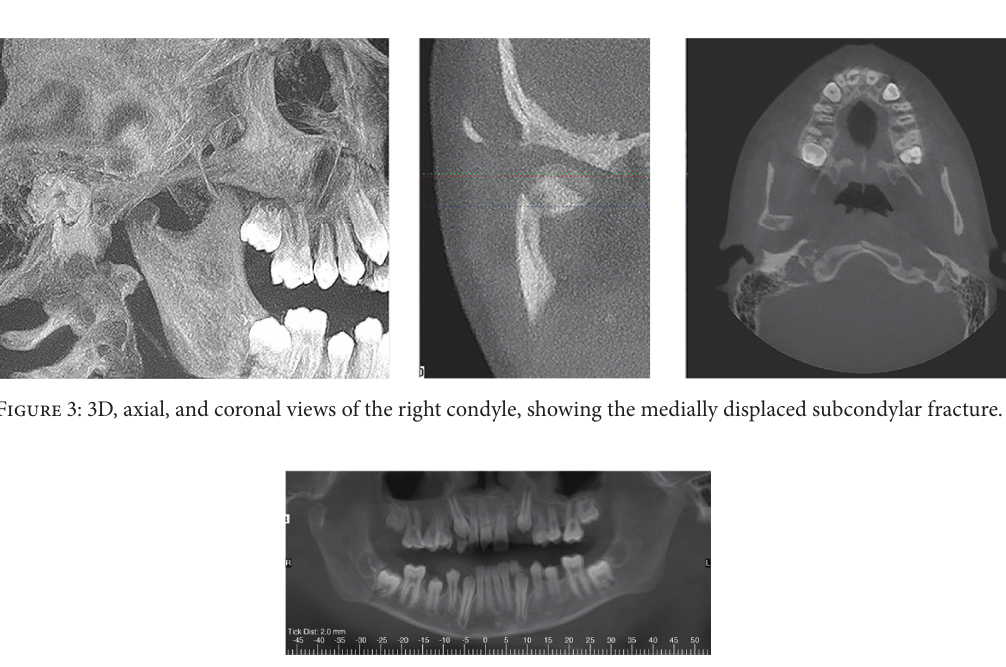
Figure 4: Initial panoramic radiography showing mandibular body fractures, avulsed maxillary left lateral incisor, and maxillary right central incisor with horizontal root fracture.